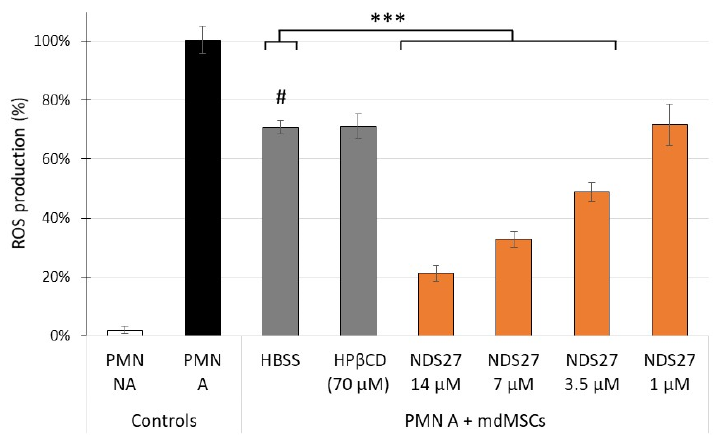
Figure 2. Effect of non-activated (PMN NA) and PMA activated neutrophils (PMN A) alone or mixed with non-loaded (HBSS) and loaded mdMSCs with HP β CD (70 µ M) or NDS27 (1, 3.5, 7, 14 µ M) in PBS on ROS production. The numbers of neutrophils and mdMSCs per well were 0.5 × 10 6 and 0.125 × 10 6 respectively. Means ± SD are shown in relative percentages versus stimulated neutrophils without mdMSCs (PMN A) defined as 100% response. Statistical analysis was considered for 5 independent experiments (2 technical replicates) with MSCs from 3 horses. *** p < 0.001 vs. HBSS, # p < 0.001 vs. PMN